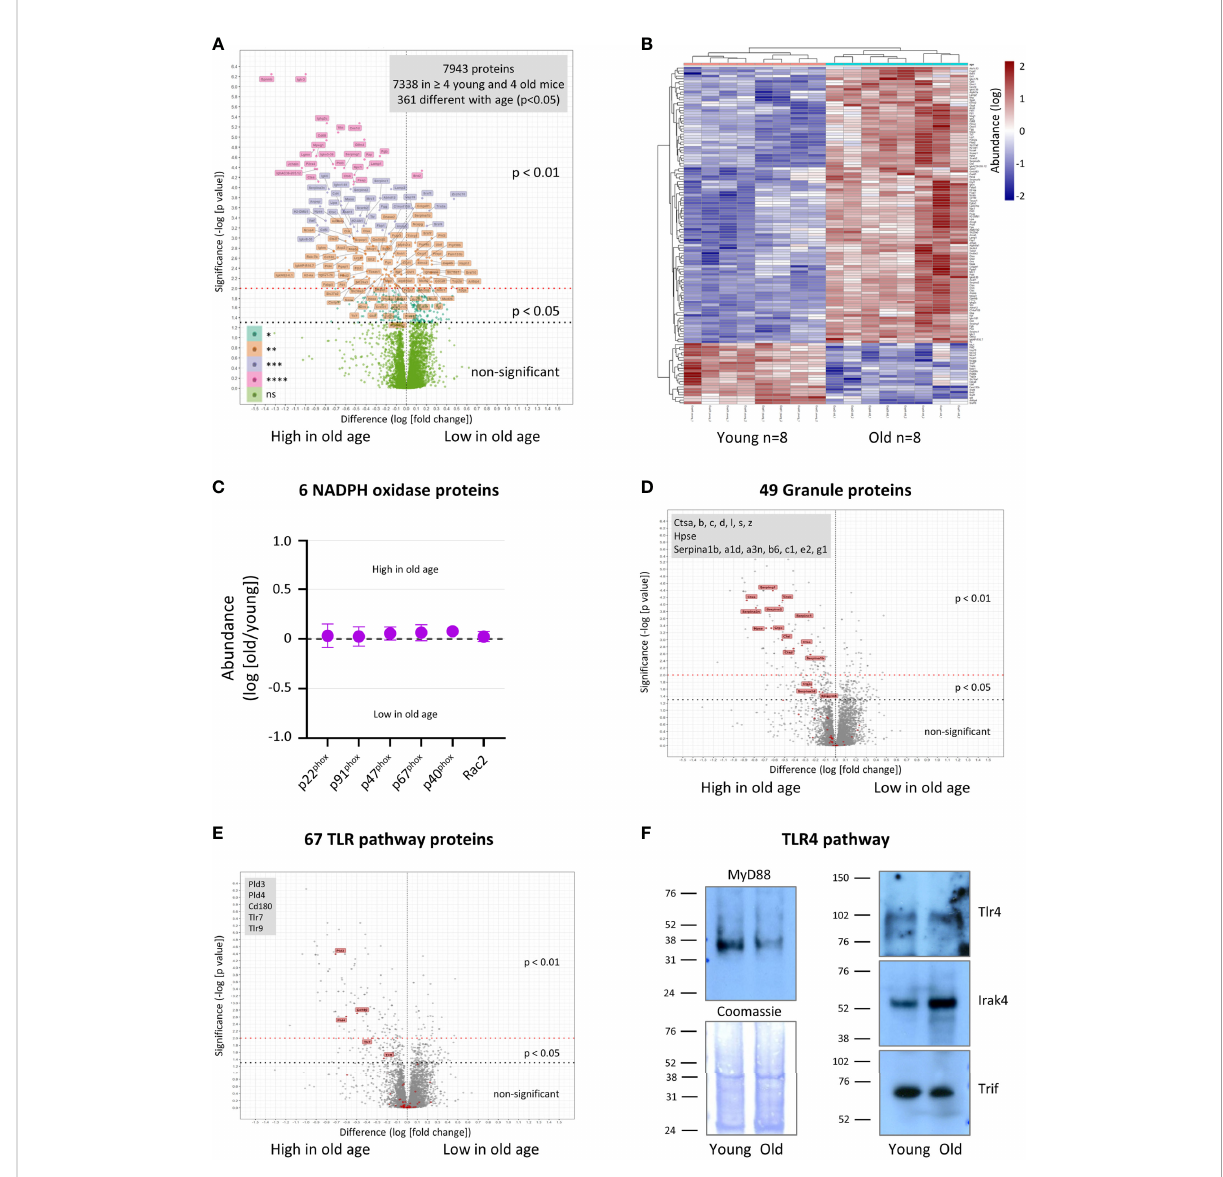
FIGURE 7 Hornigold K et al. Age-related dysregulation of the neutrophil proteome. Neutrophils were isolated to 95-98% purity from the bone-marrow of 8 young (8 weeks) and 8 old (24 months) mice, in 4 independent experiments with 2 young and 2 old mice per experiment, treated with the protease inhibitor DFP (7 mM) for 10 min at RT, washed twice, and frozen. Sample processing included protein digest and labeling with tandem mass-tags. Mass-tagged samples were combined, fractionated into 60 fractions, and analyzed by LC-MS mass spectrometry. Proteins were identi fi ed using Mascott software and their relative abundances determined using Proteome Discoverer software. (A) 7338 murine proteins were detected in at least 2 of 4 experiments (4 out of 8 mice per age) and analyzed using R software for differences in relative abundance between young and old. (B) Heatmap of proteins whose expression changed with p<0.01 between old and young mice. (C-E) Proteins were assigned to different classes and pathways by PANTHER pathway analysis and manual curation (see also Supplemental Figures 5 – 8 and Supplemental Table 1). (C) Proteins of the NADPH oxidase complex. (D) Granule-lumen proteins. (E) TLR pathway proteins. The 49 granule-lumen proteins (D) and 67 TLR pathway proteins (E) identi fi ed (red) are plotted in the context of all other proteins (grey). Deregulated granule lumen proteins (D) and TLR pathway proteins (E) are shown by red fl ags and listed in the grey boxes. (A-E) Abundances are expressed as log(old/young). Statistical signi fi cance was assessed by two-sided t-test of log(young) vs log(old) with Benjamini-Hochberg false discovery rate correction for multiple comparisons of all 7338 quanti fi ed proteins. (F) Neutrophils were isolated and DFP-treated as in (A) , lysed, and total lysates pooled (4 mice per pool per age) and western blotted for the indicated proteins of the LPS/TLR4 signaling pathway. Coomassie staining was used as loading control. Blots shown are representative from one of two pools per